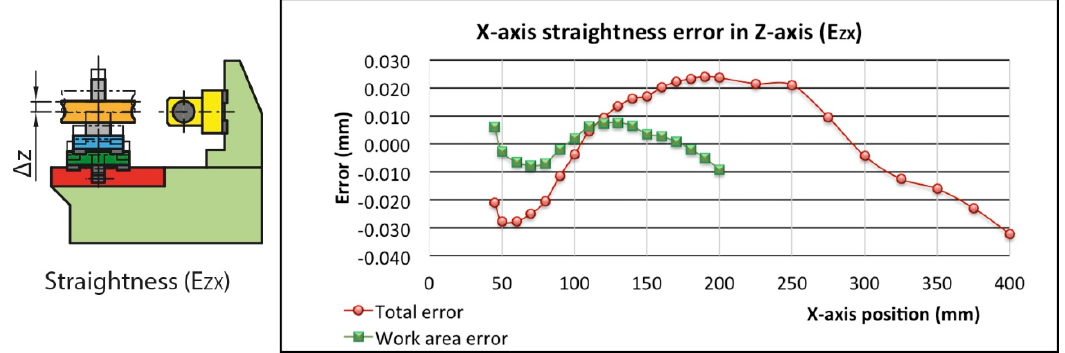
Figure 7. Straightness error (E ZX ).